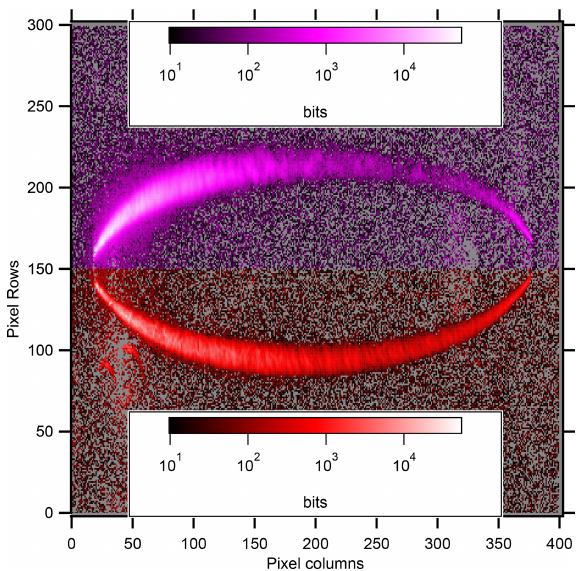
Figure 2. Colorized image of particle light scattering from room air. Individual pixel values in bits are the difference between an aerosol scattering image (light scattered by particles, gases, and the instru- ment itself) and a filter image (gases and the instrument itself). Two different logarithmic color scales are used to illustrate the scatter- ing from the 405nm laser (magenta, top) and 660nm laser (red, bottom). Curvature of the laser profile is due to the extremely wide- angle (fisheye) camera lens. In some cases the subtraction of noise can result in a small negative value, which is shown as